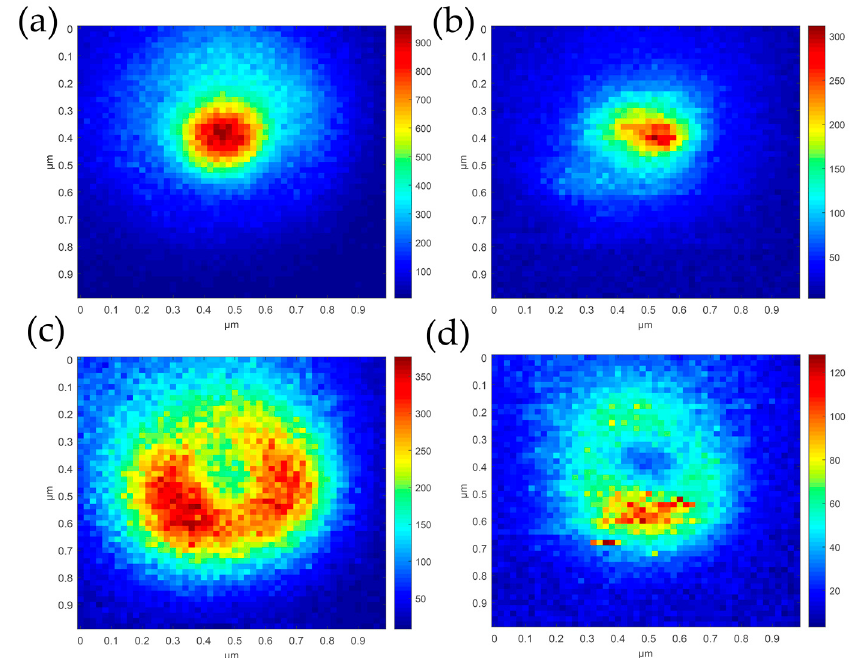
Figure 4. Intensity distributions of the tightly focused laser spot with ( a ) radial polarization and ( c ) azimuthal polarization reconstructed using the intensity of the Si Raman peak at 520 cm − 1 by raster scans of the TERS probe across the laser focal spot. Corresponding hotspot mapping patterns under ( b ) radial polarization and ( d ) azimuthal polarization reconstructed using the Ag PL intensity. Laser power: 180 µ W, 50 × 50 pixels, exposure time of each pixel: 0.5 s. The results were obtained from the same TERS probe. Azimuthal polarization was scanned before radial polarization. Each scan took 50 min.